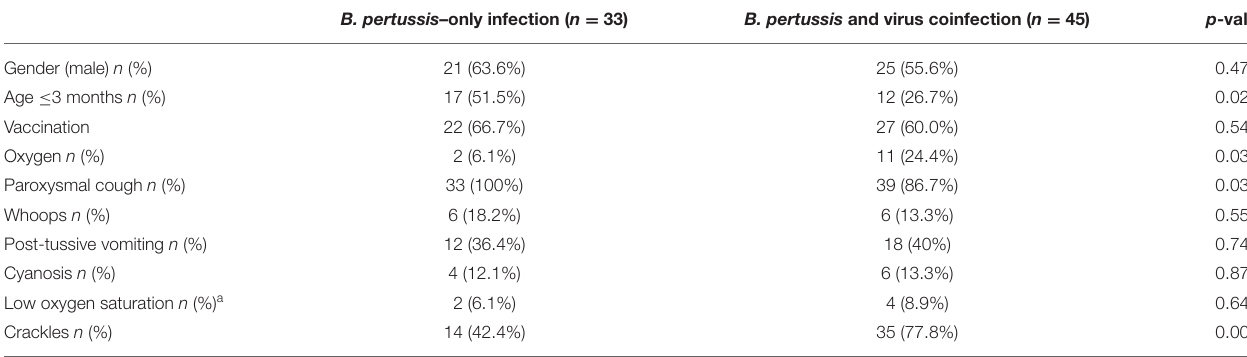
TABLE 4 | Comparison between B. pertussis –only infection and